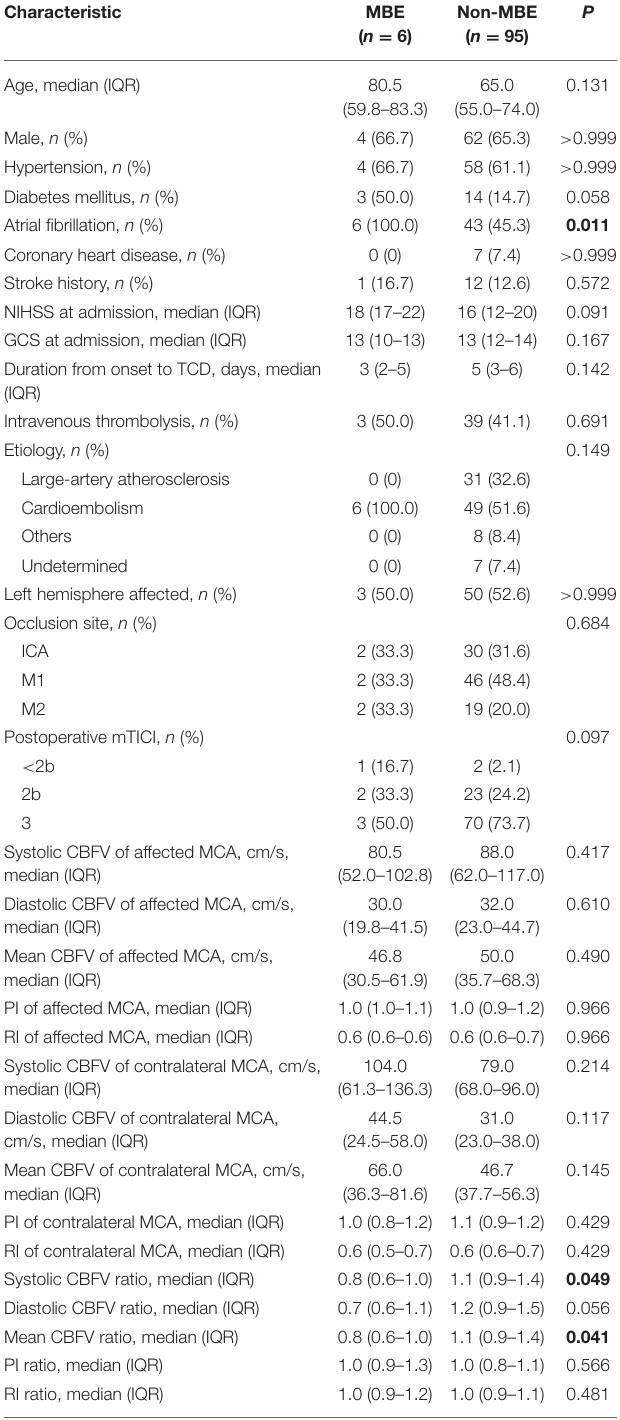
TABLE 5 | Comparison of baseline characteristics between patients with or without malignant brain edema (MBE). Characteristic MBE Age, median (IQR) 80.5